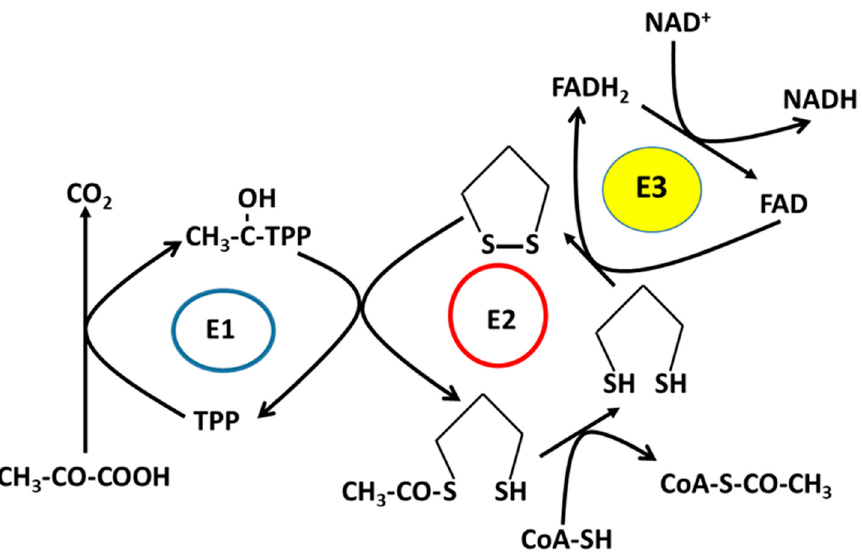
Figure 2. Lipoic acid is a cofactor of mitochondrial 2-ketoacid dehydrogenase complex, including pyruvate dehydrogenase complex, α -ketoglutarate dehydrogenase complex, and branched-chain amino acid dehydrogenase complex. The E1 subunit is 2-ketoacid decarboxylase using TPP as a cofactor; the E2 subunit is a dihydrolipoamide acyltransferase using lipoic acid as a cofactor; the E3 subunit is a dihydrolipoamide dehydrogenase, which uses NAD + as an electron acceptor for the oxidation of the lipoyl group linked to the E2 subunit. E3 catalyzes the formation of the oxidized form of lipoic acid and generates NADH in the meantime [32–34].